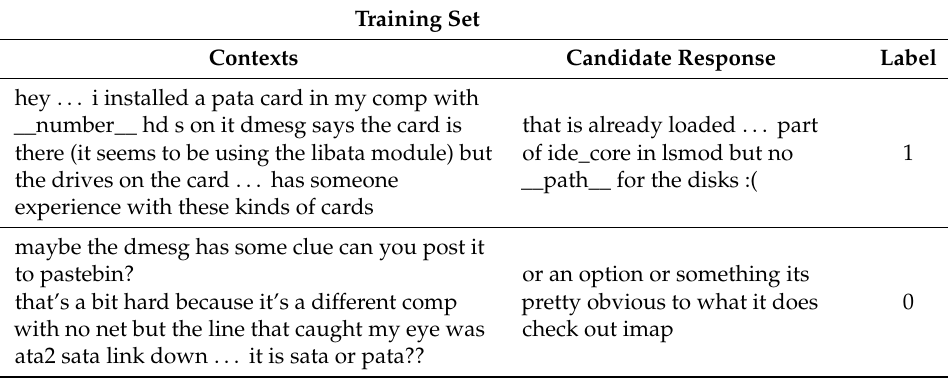
Table 1. Ubuntu Data Set (Training